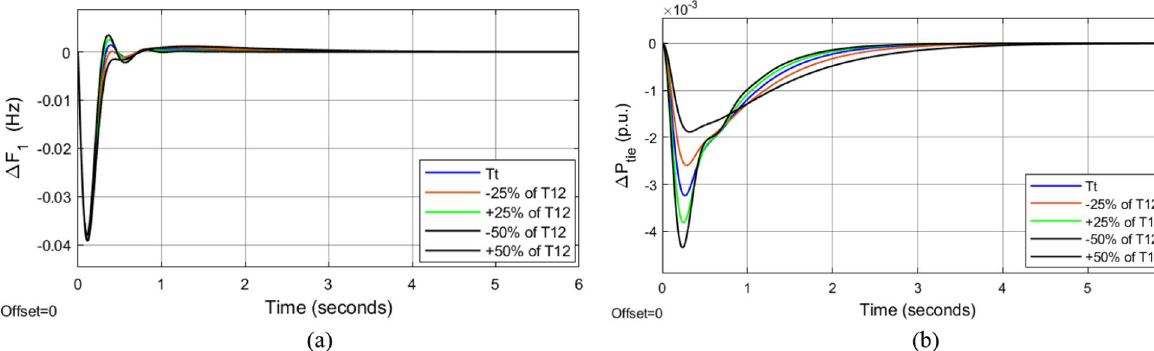
Fig. 10 Sensitivity analysis under variation of T 12 : a ΔF 1 and b Δ P tie